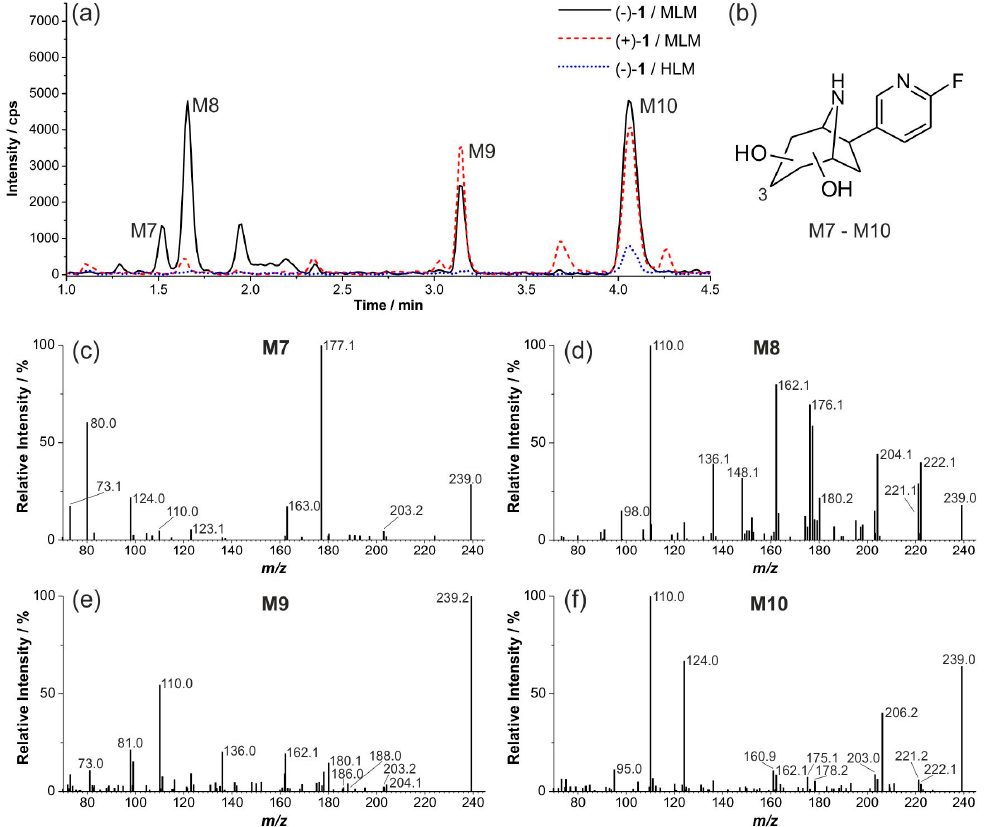
Figure 9. Formation of dihydroxylated metabolites: ( a ) multi reaction monitoring (MRM) chromatograms (239.1/110.0) of extracts resulting from incubations of both (+)- 1 and ( − )- 1 with liver microsomes (37 °C, 90 min); ( b ) general formula of dihydroxylated metabolites of (+)- 1 ; and ( c – f ) enhanced product ion (EPI) spectra of M7 to M10 (products of m/z 239.1, CE 33, CES 0).